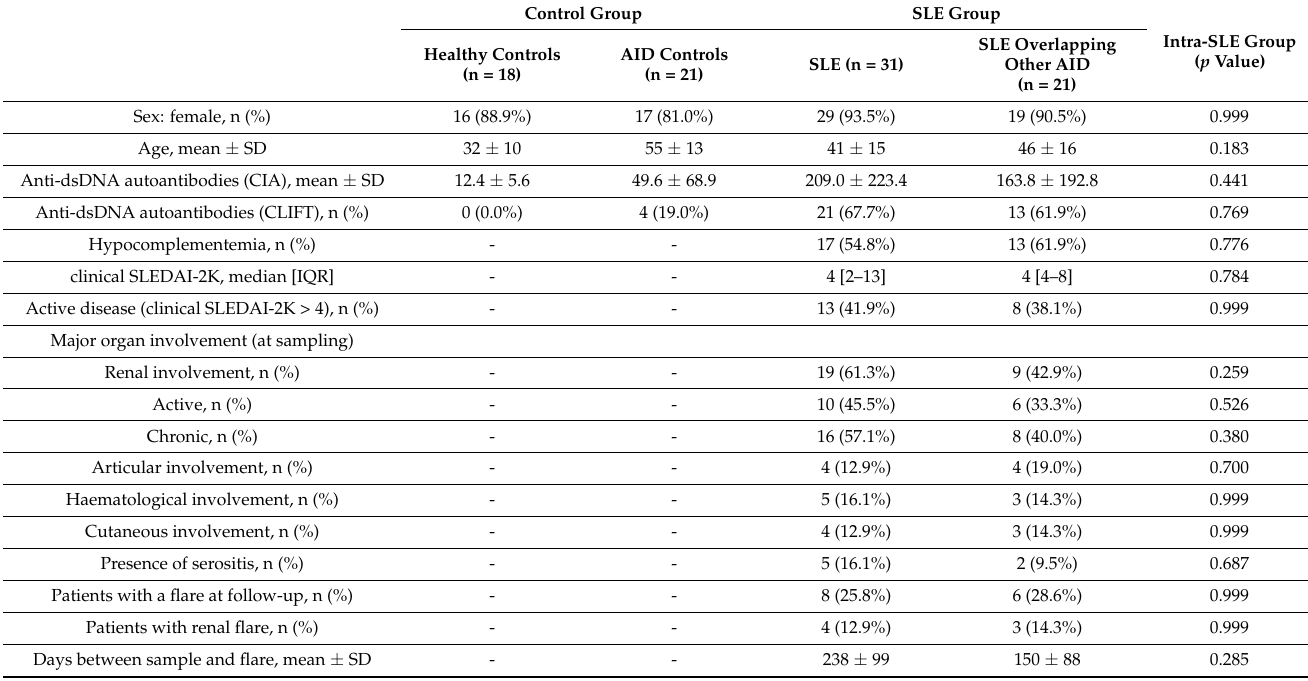
Table 1. Demographic and clinical characteristics of the study